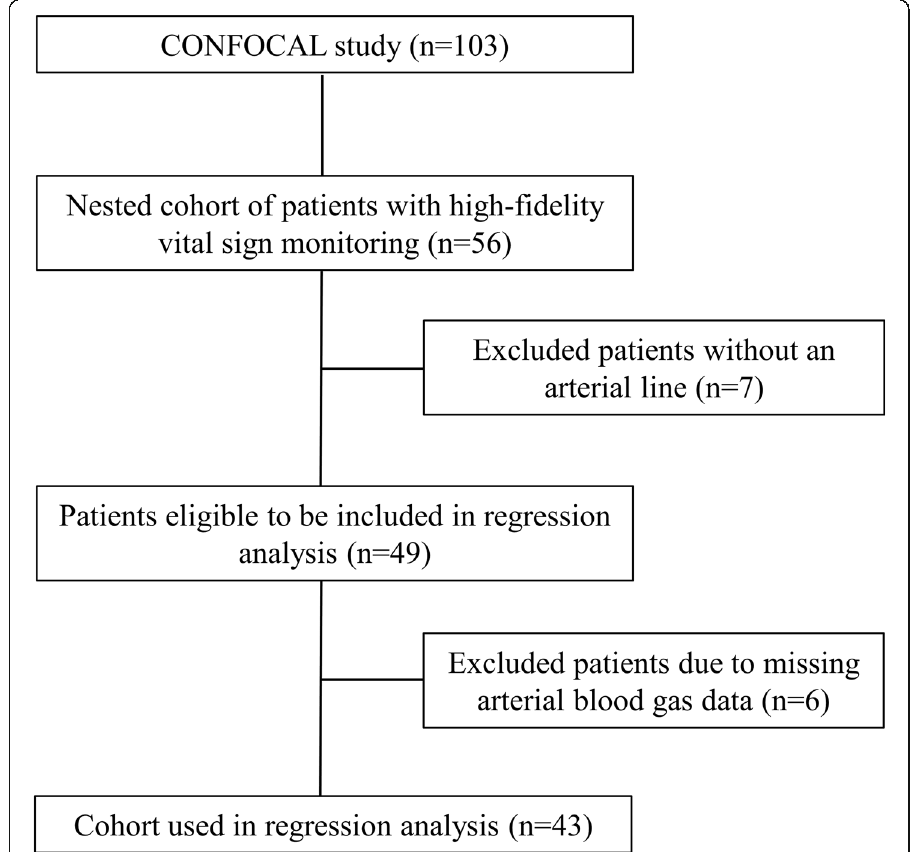
Fig. 1 CONSORT diagram demonstrating patient inclusion and exclusion during patient recruitment